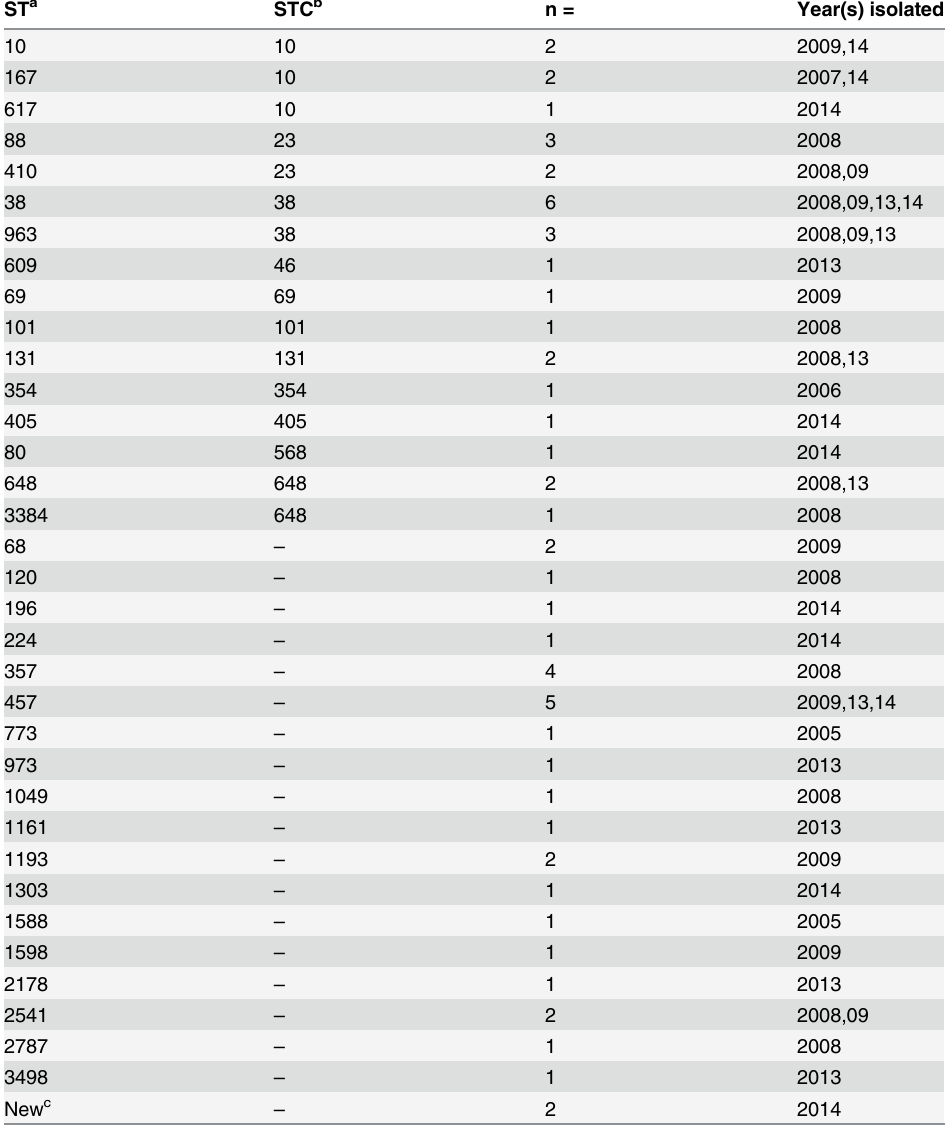
Table 2. Sequence types of E . coli strains carrying IncI1- bla CMY-2 plasmids. ST a STC